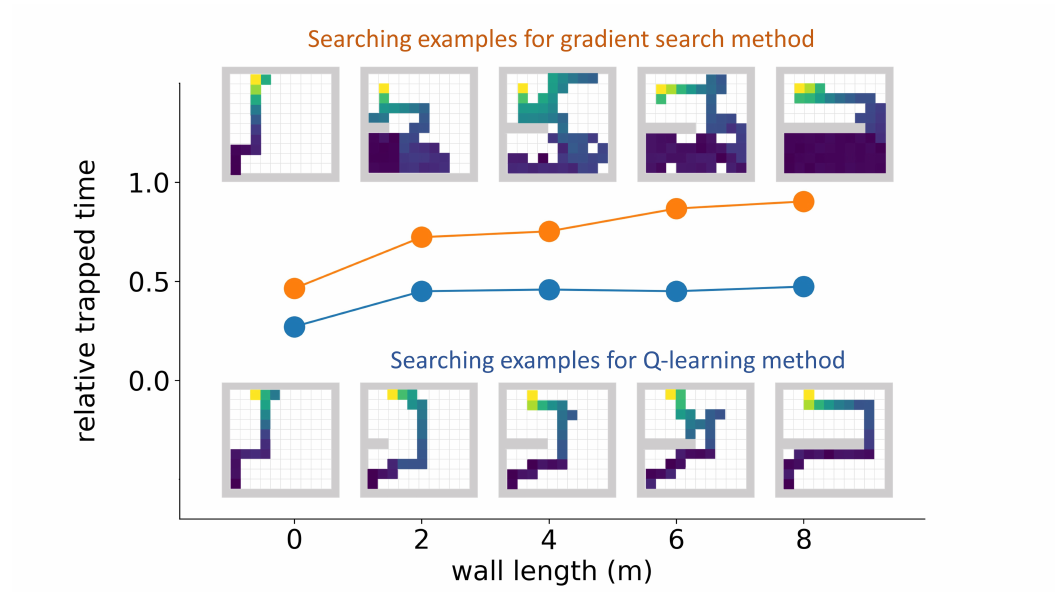
Figure 10. Detector trapping test 1. In this trapping test, simulation areas with different wall lengths were tested. The relative trapped time was defined as the percentage of the time the detector stayed in the lower 40% part of the simulation area during the whole searching process. The orange curve represents the mean relative trapped time of the gradient search method, and the blue curve represents the mean relative trapped time of the Q-learning method. The example searching paths for both algorithms in different wall lengths are also drawn in the figure. For all the searching path examples, the detector initialization point was at the lower left corner, the radiation source was at the upper left corner, and the color of the path represents the mean radiation intensity (blue is low, and yellow is high). The Q-learning algorithm was not trapped by walls, while the gradient search method was trapped by